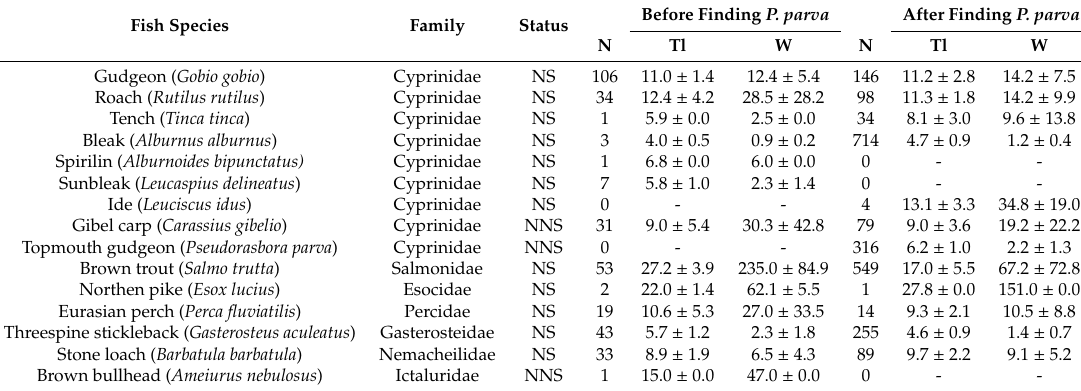
Table 2. Total length (Tl, cm) and biomass (W, g) as the mean ± standard deviation (SD) of fish species in the Ciemiega River; N—number of fish, NS—native, and NNS—non-native